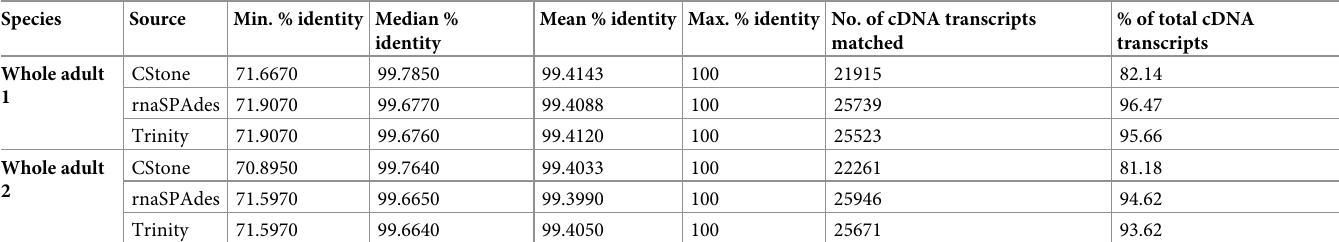
Table 6. Summary of percent identity between contigs and cDNA reference transcripts for the alignments represented in Fig 8 based on simulated data. Species Source